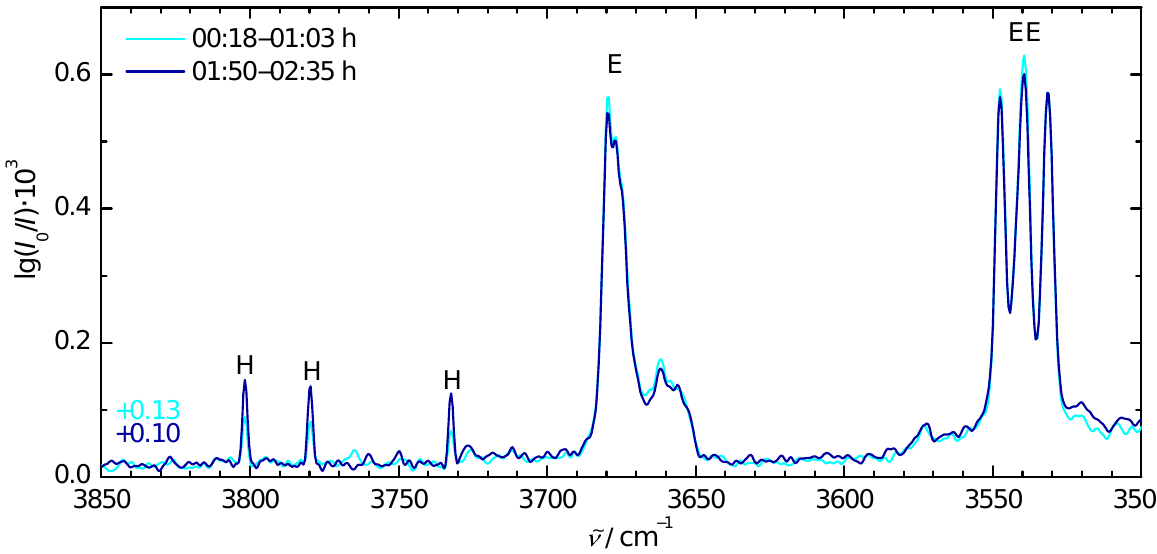
Figure 6. Rising intensity of rotationally cold water transitions (H) during gas-recycling operation. With increasing time difference to the start of the recycling operation (light blue, to dark blue), the intensity of the monomeric water lines at 3802, 3780, and 3732 cm − 1 increases in the spectrum of 1.30 hPa (0.17%) ethanol (EtOH) in helium. The EtOH monomer (E) and dimer (EE) OH stretching bands are also marked in the spectrum. To illustrate the water increase, the baselines of the spectra were aligned near the water lines by displacing them along the ordinate, as indicated above the